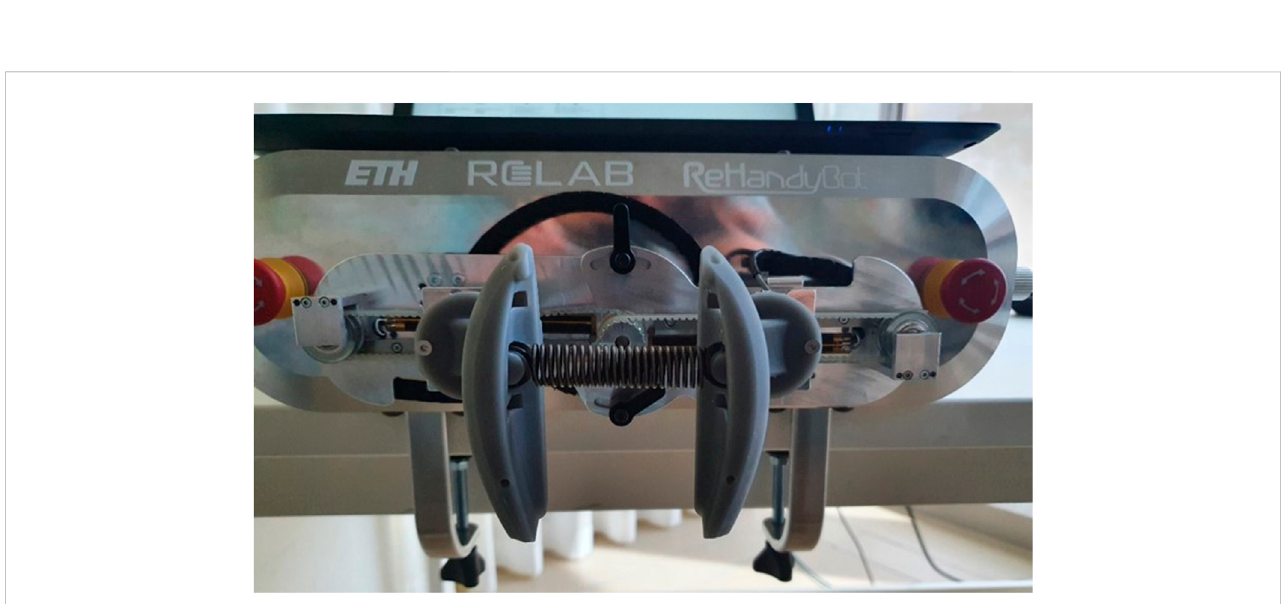
FIGURE 4 Setup for the stiffness identi fi cation experiment. Linear springs with known stiffness (0.97 or 1.27 N/mm) were applied on the inside of the fi nger pads through two cylindrical constraints while applying the position perturbations. This allowed to validate the performance of the perturbation-based stiffness identi fi